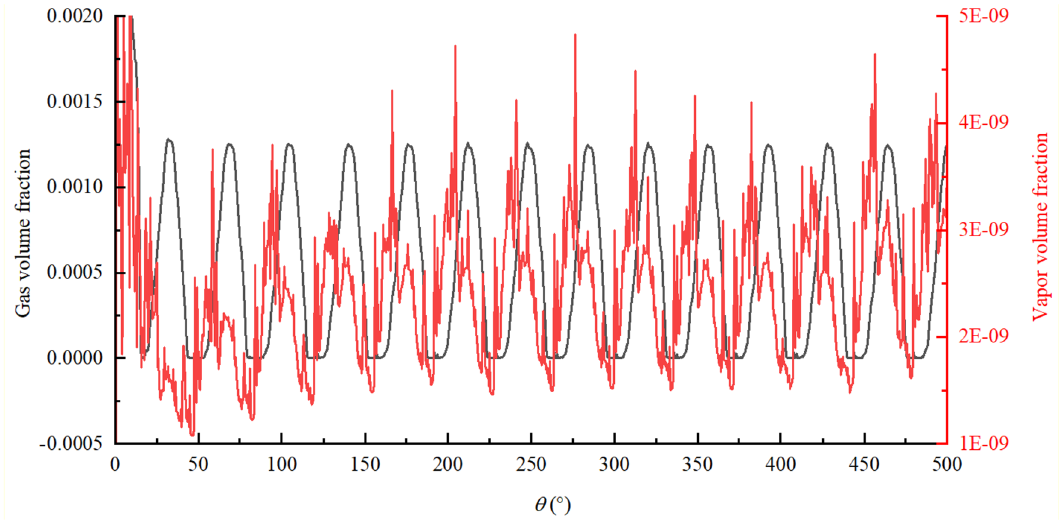
Figure 19. The variation of gas volume fraction and vapor volume fraction in rotor region with rotation